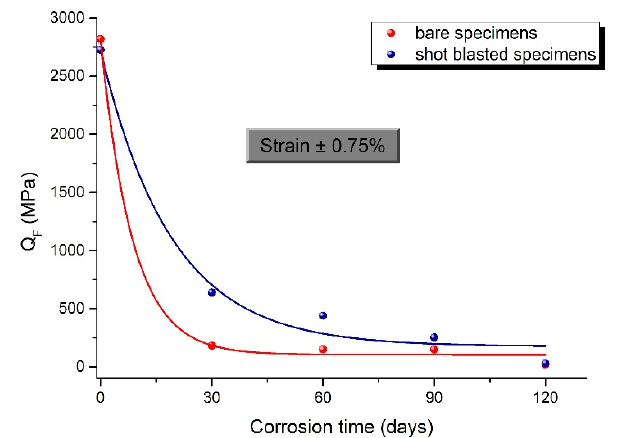
Figure 11. Extracted fitting curves of fatigue damage indicator Q F as a function of corrosion exposure for imposed deformation ±0.75% for both groups of specimens.